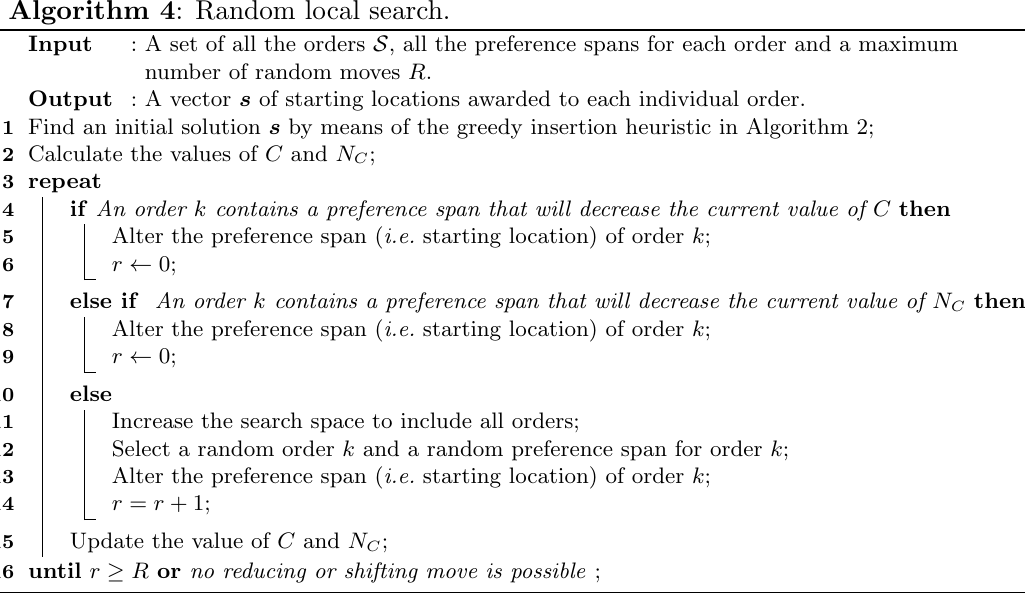
Algorithm 4 : Random local